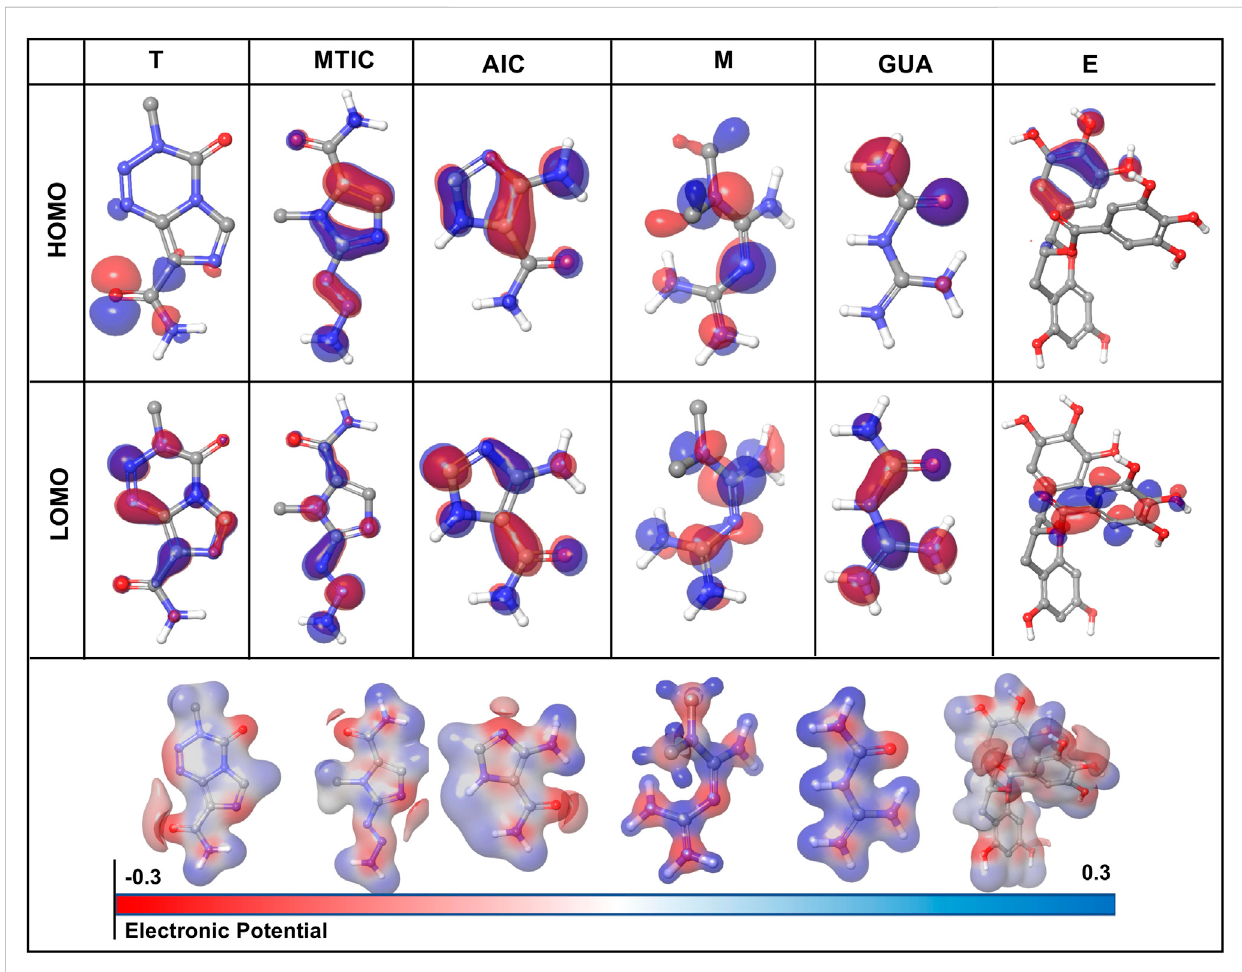
FIGURE 7 Graphical representation of density functional theory (DFT) calculation of the drug-ligand complex in terms of HOMO (highest occupied molecular orbitals) and LUMO (lowest unoccupied molecular orbital).